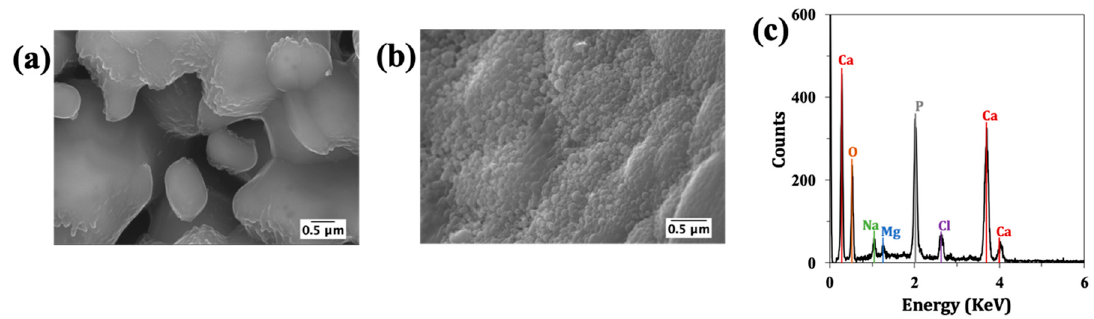
Figure 5. Microstructural and chemical features of the sca ff olds after 14 days of immersion in simulated body fluid (SBF) solution: ( a ) SEM micrograph of uncoated BCP sca ff olds; ( b ) SEM micrograph of BG-coated BCP; ( c ) EDS analysis of the precipitate.